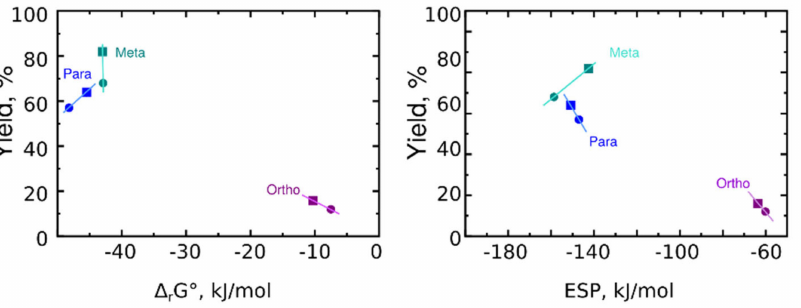
Figure 8. Reaction yield vs. Gibbs energy ( left ) and electrostatic potential at the nitrogen atom ( right ). Compounds with CONHMe groups are shown as squares. Compounds with CONH 2 are shown as